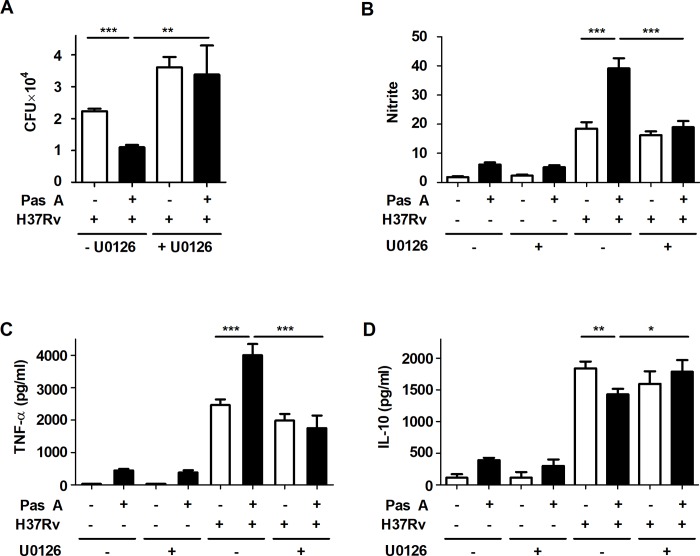
Pasakbumin A controls the intracellular Mtb growth and production of inflammatory mediators through ERK-mediated signaling.Raw264.7 cells were pre-treated with U0126 (10 μM) for 1 h and then stimulated with pasakbumin A (Pas A, 10 μM) during H37Rv infection (MOI of 1 or 5). (A) Intracellular bacterial survival was determined by counting the number of CFUs at 3-weeks after inoculation. (B-D) Culture supernatants were measured for the production of (B) NO, (C) TNF-α and (D) IL-10 at 48 h. The experiments were performed in triplicate. *, p<0.05; **, p<0.01 and ***, p<0.001.